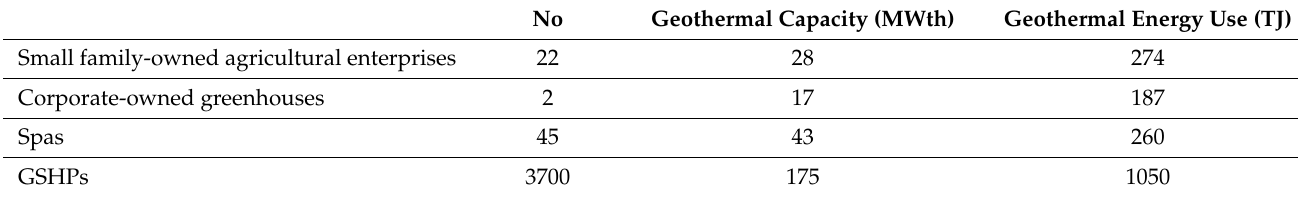
Table 1. Geothermal heat use in Greece per application in December 2020. No Geothermal Capacity (MWth) Geothermal Energy Use (TJ) Small family-owned agricultural enterprises